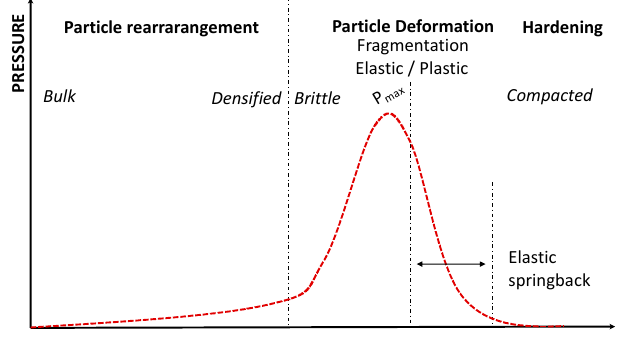
Figure 1. Illustration of the powder compression curve divided into particle rearrangement, fragmentation, elastic and plastic deformation and hardening. The figure has been modified from Stelte, W. et al., [1].